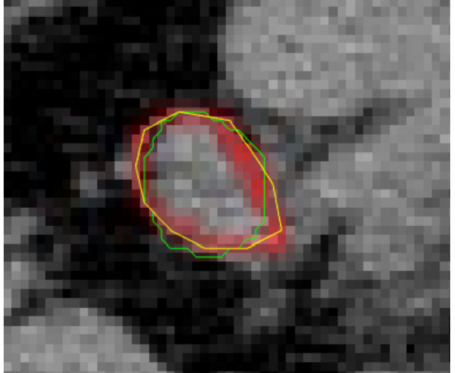
Figure 11. Comparison between the labeling by the proposed method and the doctor. The doctor annotated the image with a yellow line; the green line was drawn using the proposed method. After calculation with the pixels, according to the doctor’s labeling, the accuracy rate of the proposed method was 95.03%, and the error rate was